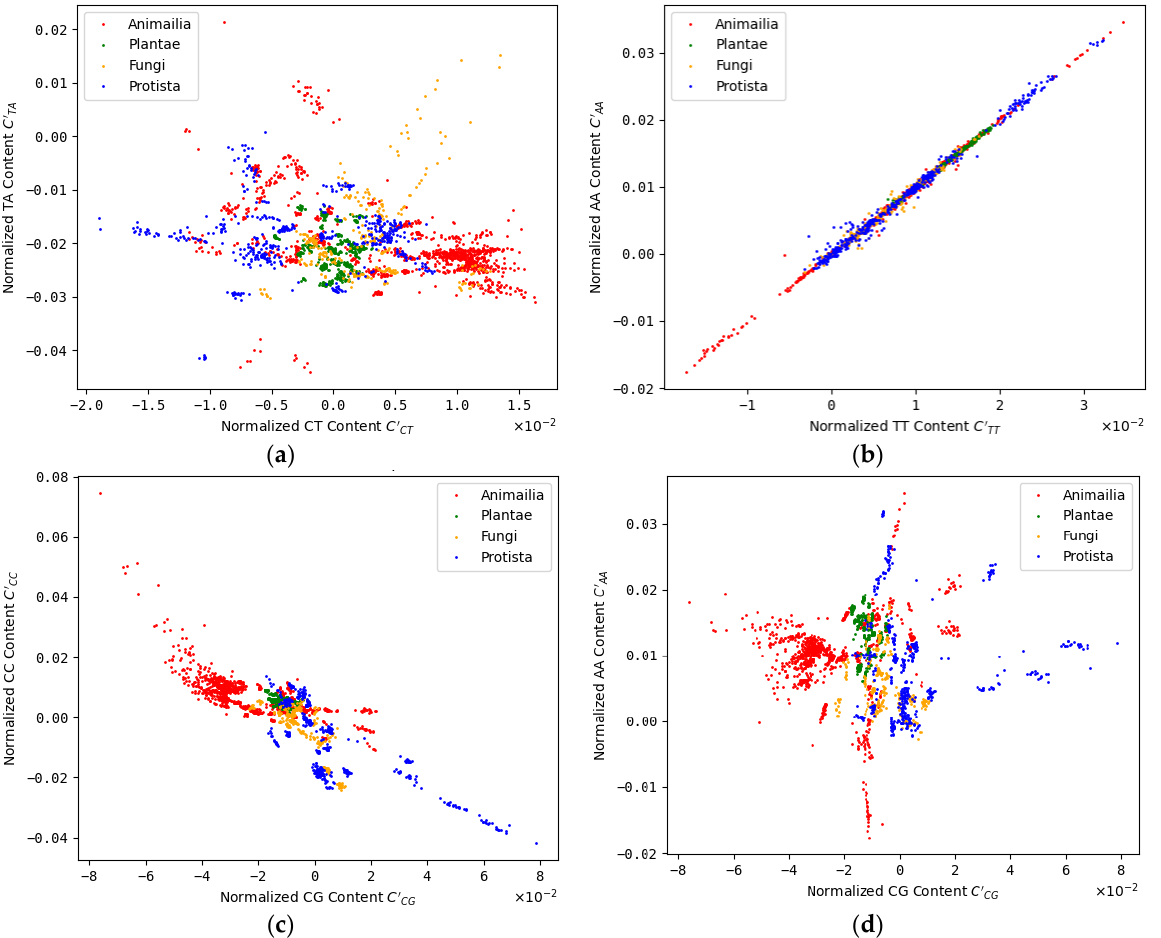
Figure 1. Examples for dinucleotide relations: Representative collection of possible relations be- tween normalized dinucleotide contents (see Section 2.1) on all eukaryotic chromosomes analyzed. ( a ) Moderate anti-correlation between normalized CT and AT contents (correlation value: − 0.51), ( b ) high correlation between normalized TT and AA contents (correlation value: 0.997), ( c ) high anti-correlation between normalized CG and CC contents (correlation value: − 0.82), ( d ) no significant correlation between normalized CG and AA contents (correlation value: − 0.035).